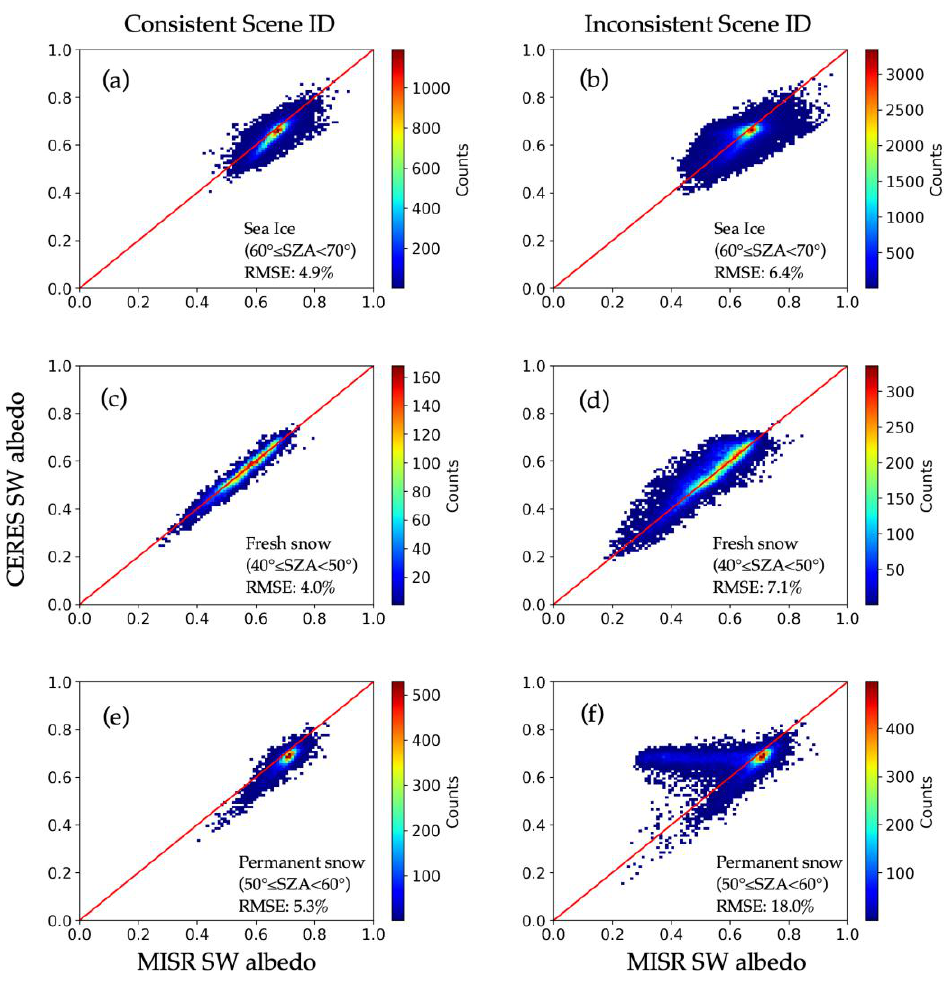
Figure 4. Same as Figure 3 but for ( a , b ) overcast fresh snow with solar zenith angle (SZA) between 40° and 50°, ( c , d ) overcast permanent snow with SZA between 50° and 60°, and ( e , f ) overcast sea ice with SZA between 60° and 70°.